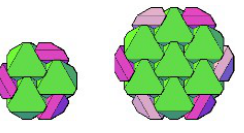
Figure 10. Hexagonal slabs composed of hexgonal and rhombic components.